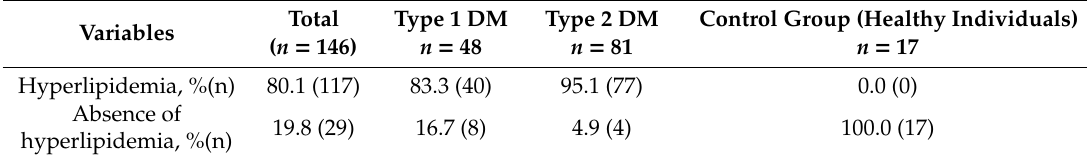
Table 4. Frequency of hyperlipidemia in patients with DM and in the control